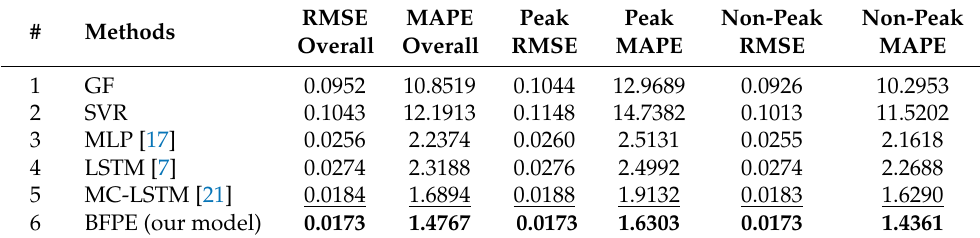
Table 2. Summary of performance outcome on CALCE